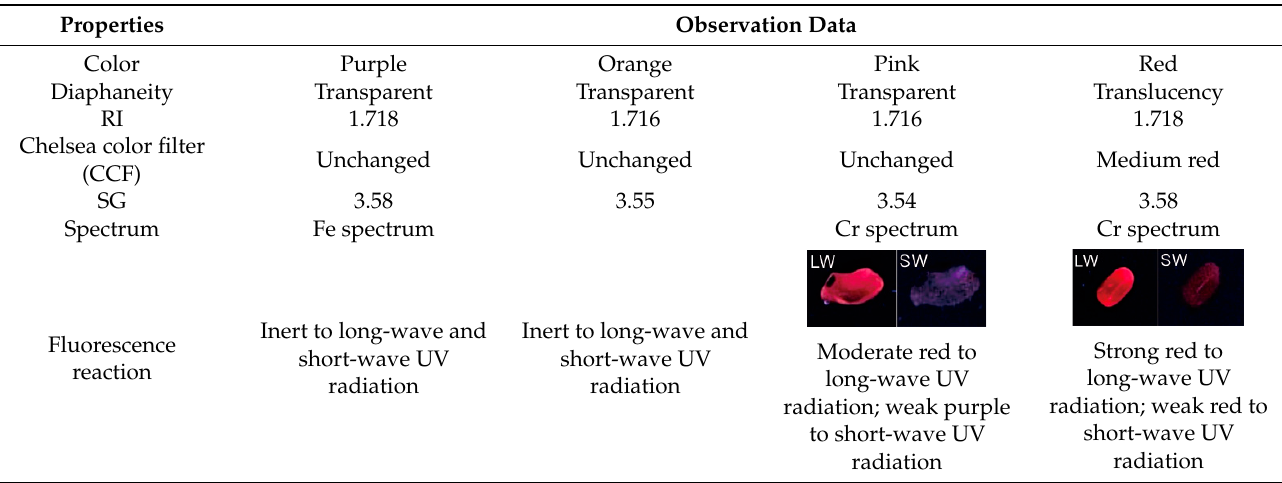
Table 1. Summary of gemological properties of spinel from Mogok.